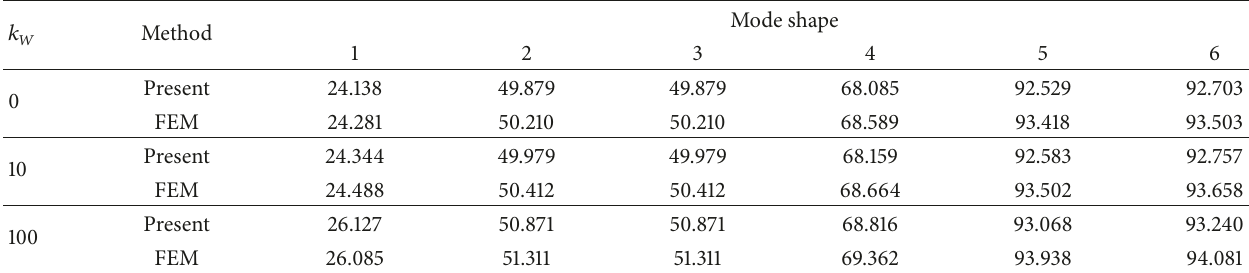
Table 3: Frequency parameter Ω for angle-ply (0/90 ∘ ) square thin plate on the Winkler foundation with CCCC boundary condition (Material II) .